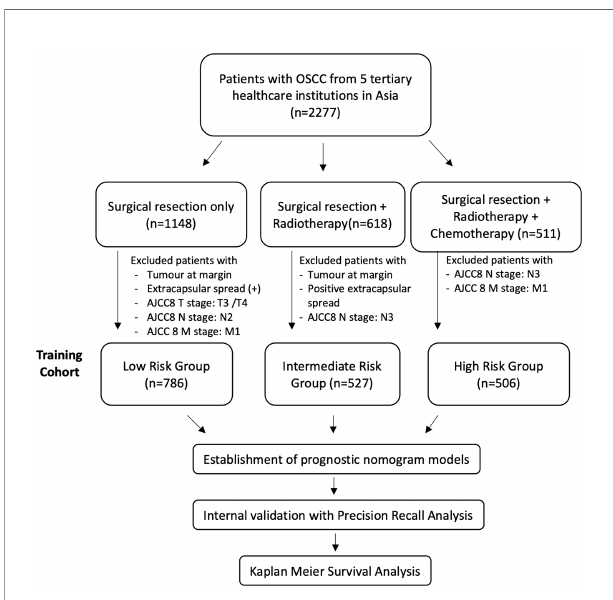
FIGURE 1 | Flowchart of study cohort selection